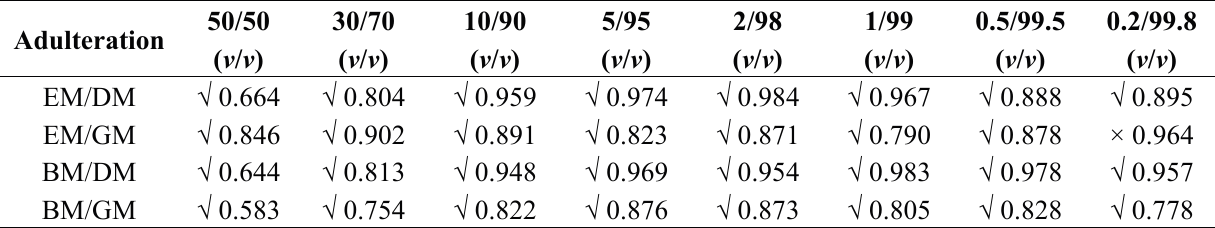
Table 2. The identification ability (expressed by the symbol  = Yes, × = No) of different percentages of DM and GM adulteration obtained by the Biotyper analysis; the correspondent correlation coefficients are also